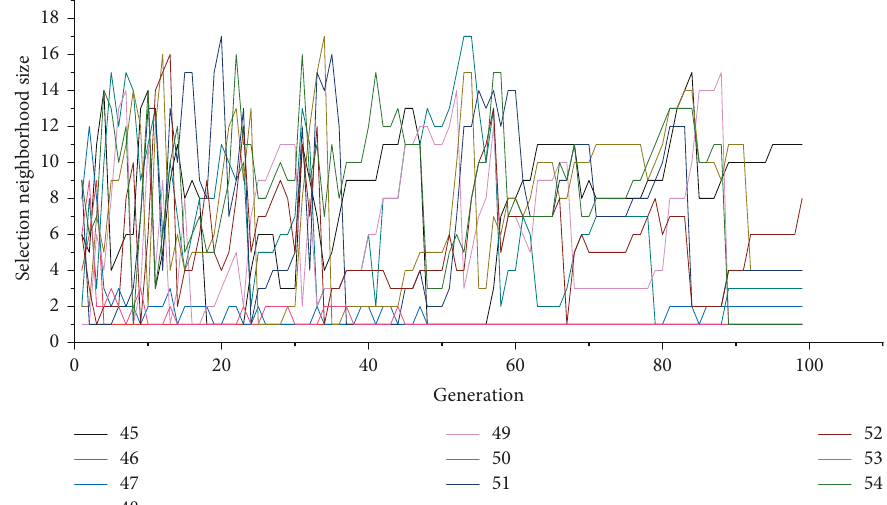
Figure 11: Variation of selection neighhorhood sizes for individuals 45 to 54.